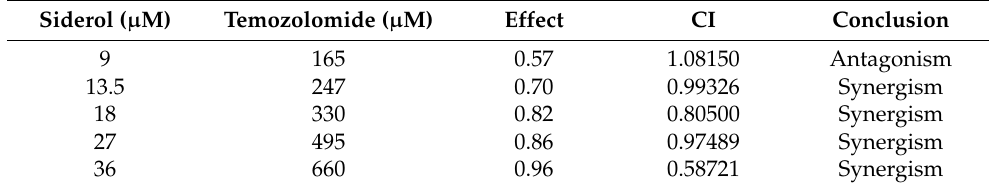
Table 2. Assessment of combinatorial effect of siderol and TMZ in T98 cells. Concentrations of each substance, the effect (% mortality), and CI of each combination are represented. Data were determined by CompuSyn software. CI allows quantitative determination of drug interactions, where CI < 1, =1 and >1 indicates synergism, additive effect and antagonism, respectively. Siderol ( μ M) Temozolomide ( μ M) Effect CI Conclusion